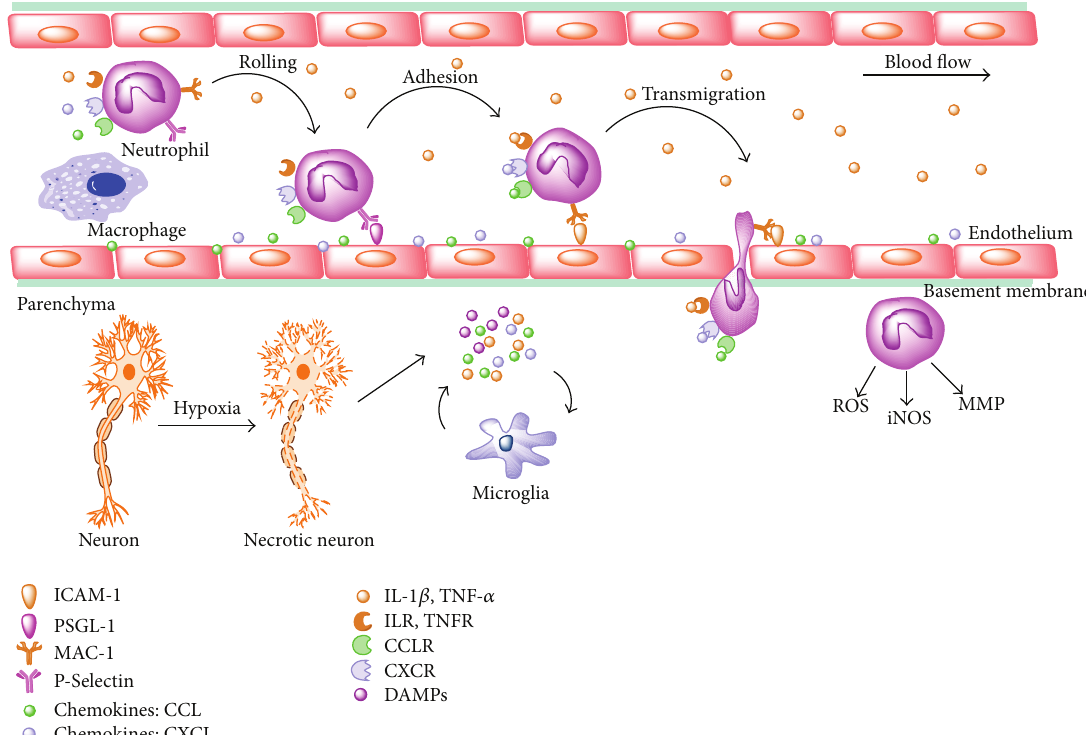
Figure 1: The process of neutrophil infiltration into the cerebral parenchyma. Injured brain cells release DAMPs and cytokines within lesion area and into the vessel lumen. Subsequently, CAMs on the surface of endothelium and neutrophils are induced, participating in the series steps of neutrophil rolling, adhesion, and transmigration. ICAM-1, intercellular cell adhesion molecule-1; PSGL-1, P-selectin glycoprotein ligand 1; MAC-1, macrophage adhesion molecule 1; CCL, monocyte chemoattractant protein; CXCL, chemokine (C-X-C motif)